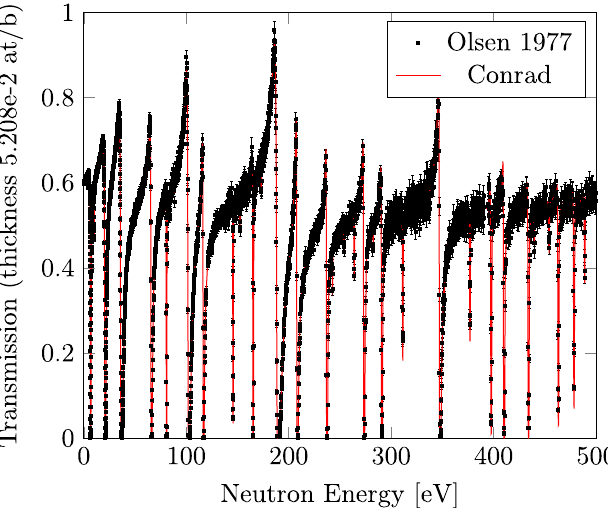
Fig. 4. Comparison between experimental values and theoretical description for 238 U neutron induced transmission. Figure taken from [11].